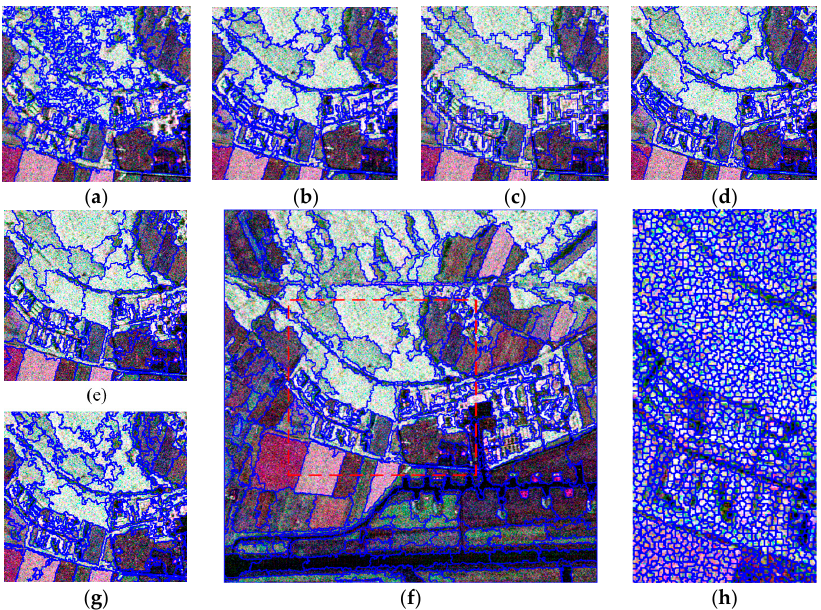
Figure 8. Segmentation results of the two-look ESAR PolSAR image using different methods: ( a ) FFD, ( b ) FPD, ( c ) IFGB, ( d ) IFWS, ( e ) IFKS, ( f ) IFGS, ( g ) IFGS-S, and ( h ) SLIC (local enlarged drawing of central left part of the superpixel map). ( a – e ) and ( g ) show screenshots of the results in the red dashed rectangle of ( f ).